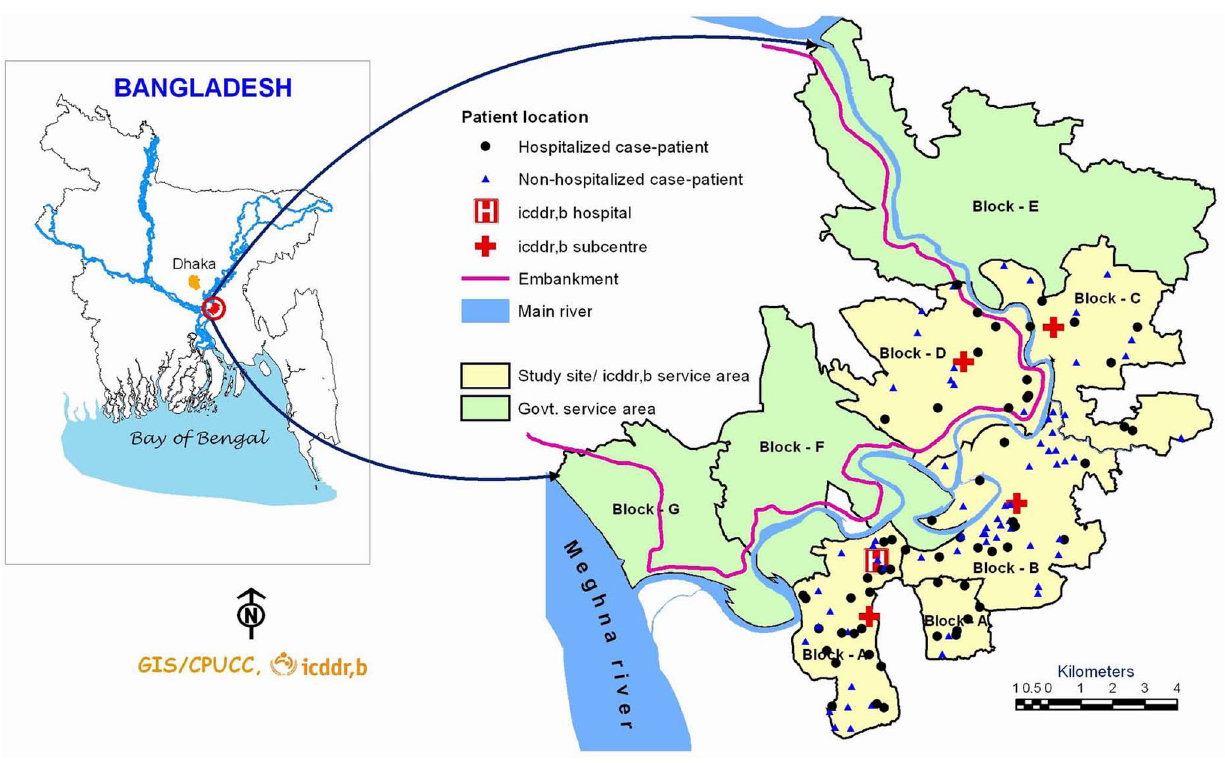
Figure 1. Study site and location of all severe acute respiratory infection cases, Matlab, Bangladesh–2010.